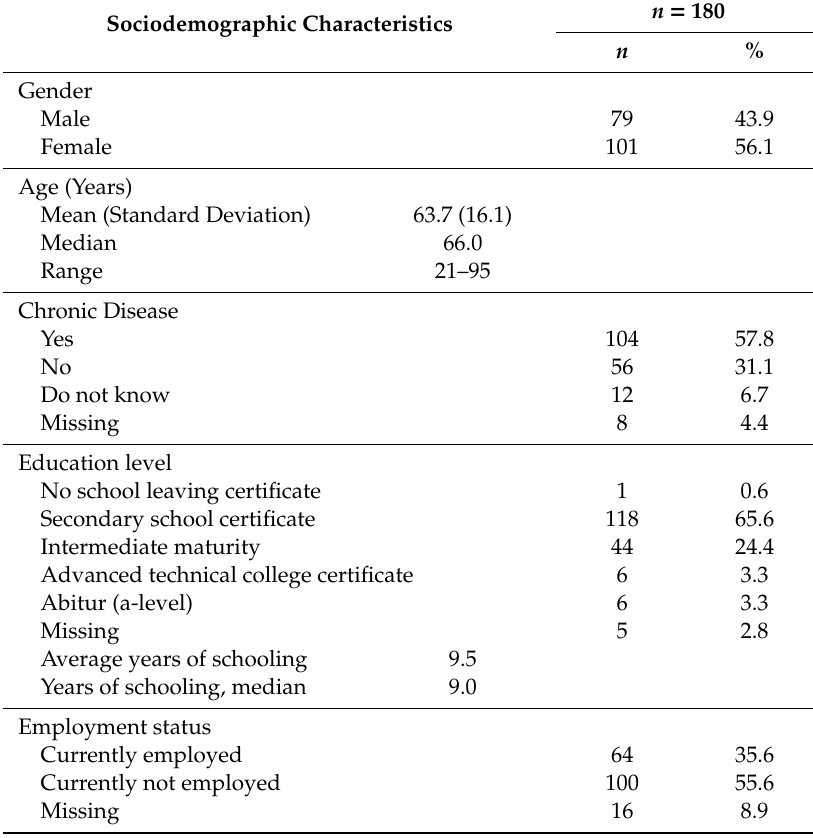
Table 1. Sociodemographic characteristics of the study participants.